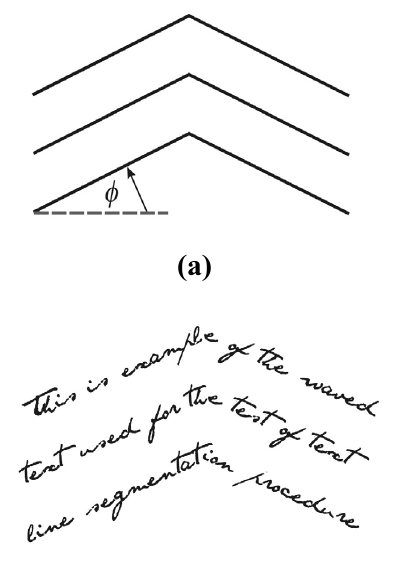
Figure 4. Multi-line fractured text: (a) Reference line definition. (b) Text over reference line. (c) English text. (d) Bengali